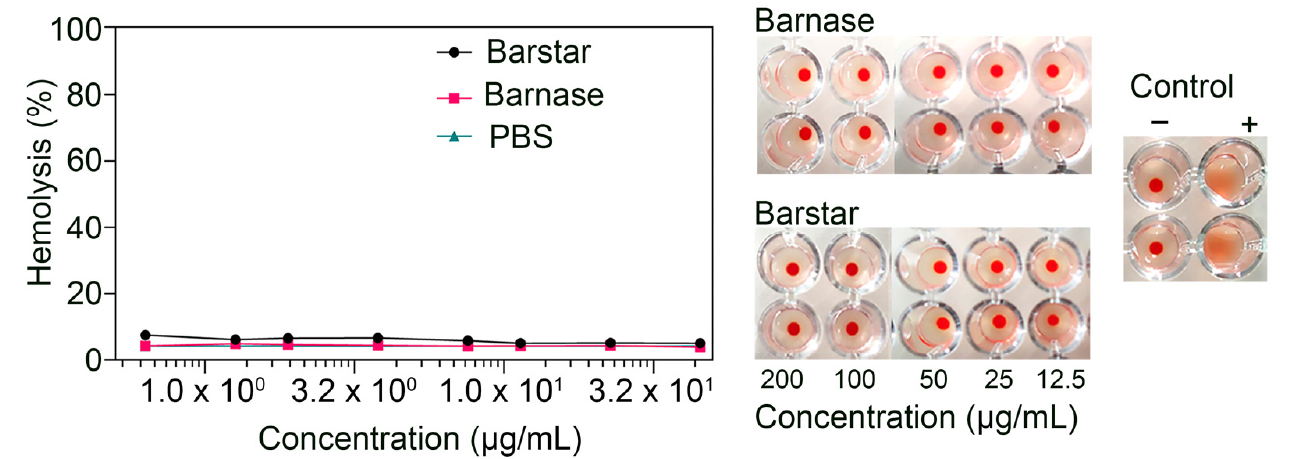
Figure 7. Hemotoxicity study of barnase and barstar. The intensity of erythrocyte lysis after the incubation with barnase or barstar at various concentrations is presented as a percentage of the positive control. A sample of erythrocytes lysed with distilled water was used as a positive control, and a sample of erythrocytes incubated in PBS was used as a negative control. The data are accompanied by the agglutination study. RBCs were sequentially incubated with rat anti-RBC antibodies (TER119) and goat anti-rat antibodies were used as a positive control. A sample of RBCs incubated in PBS was used as a negative control.